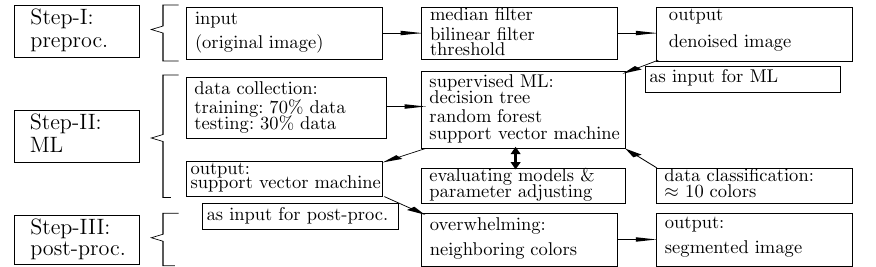
Fig. 3: The workflow chat for the image segmentation (preproc.: preprocessing, post-proc.: post- processing).